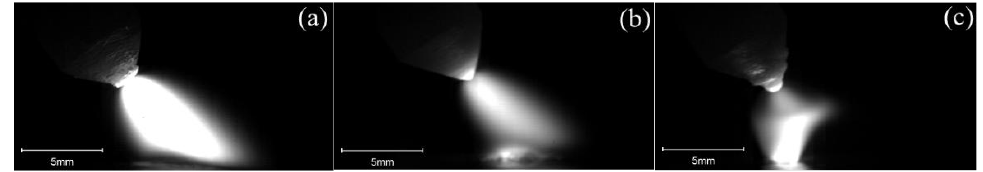
Figure 2 . Snapshots of high-speed camera for argon arc with different hydrogen concentrations: ( a ) 0, ( b ) 30, and ( c ) 50 vol%.